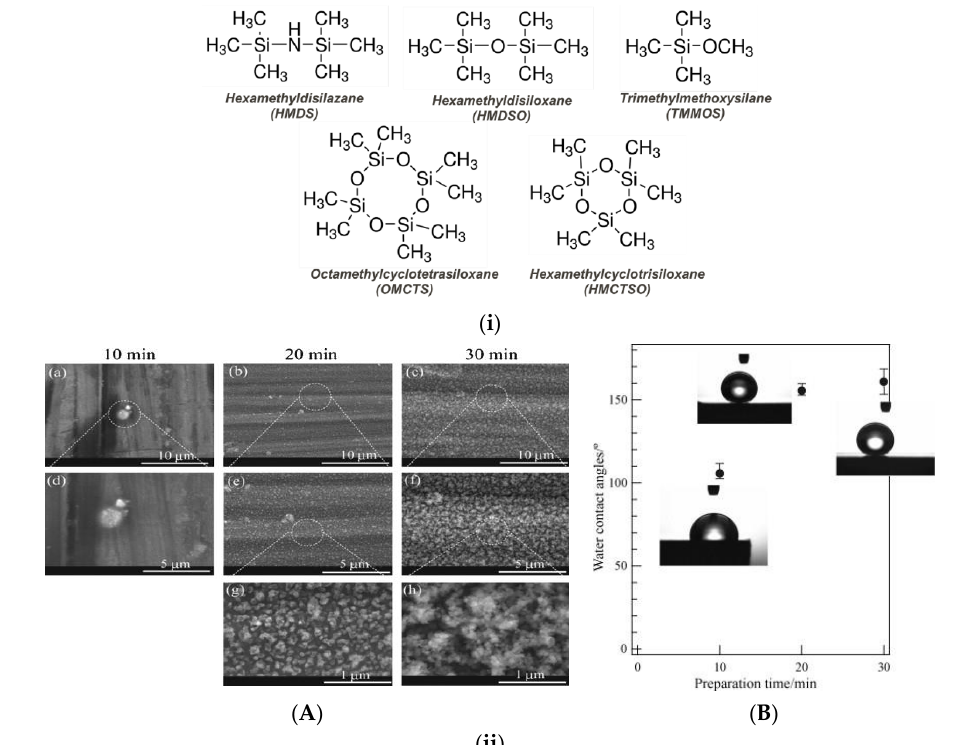
Figure 10. ( i ) Most common organosilicon precursors for the single-step deposition of plasma-polymerized superhydrophobic coatings either in low or atmospheric pressure. ( ii ) Microwave low-pressure plasma deposited coatings using a gas mixture containing trimethylmethoxysilane and Argon on magnesium alloy AZ31: ( A ) SEM images of the coatings and ( B ) water contact angle measurements for different plasma deposition times. Reproduced with permission from [82].